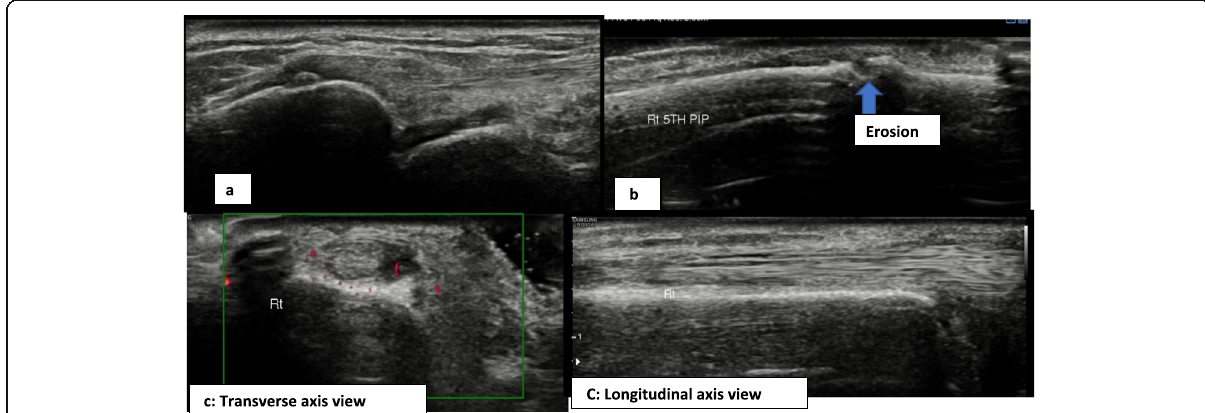
Fig. 1 A 57 years old asymptomatic patient, ACPA negative, anti-dsDNA positive and SLEDAI-2K score of 23. a Left radio-lunate joint with grade 2 SH and effusion. b Right PIP with grade 2 SH and erosion. c Right 6th extensor compartment grade 2 tenosynovitis with grade 1 PD